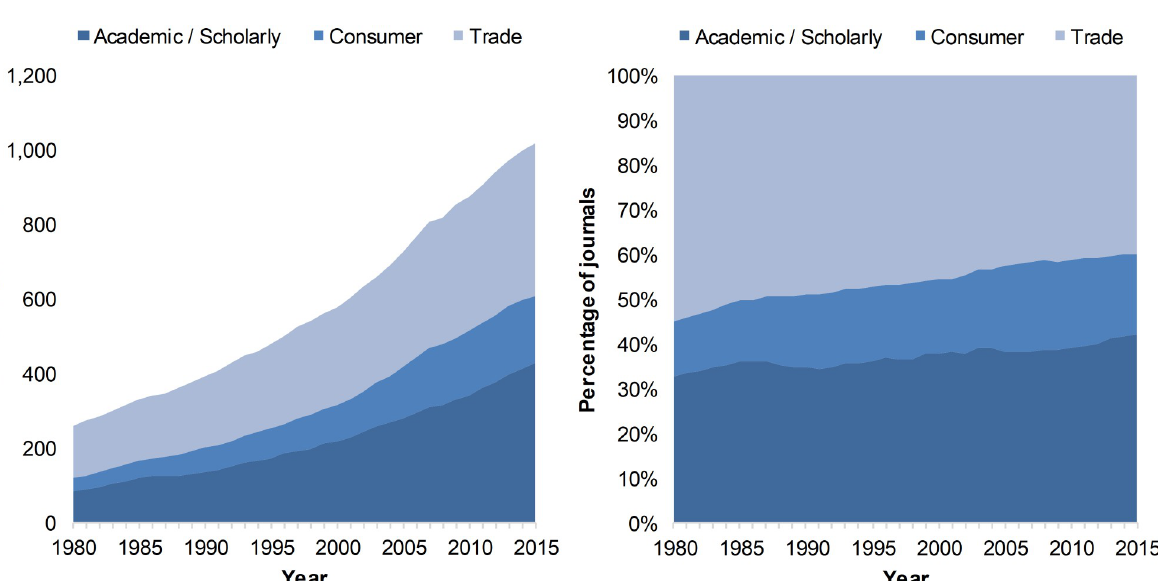
PLOS ONE | https://doi.org/10.1371/journal.pone.0276840 November3,